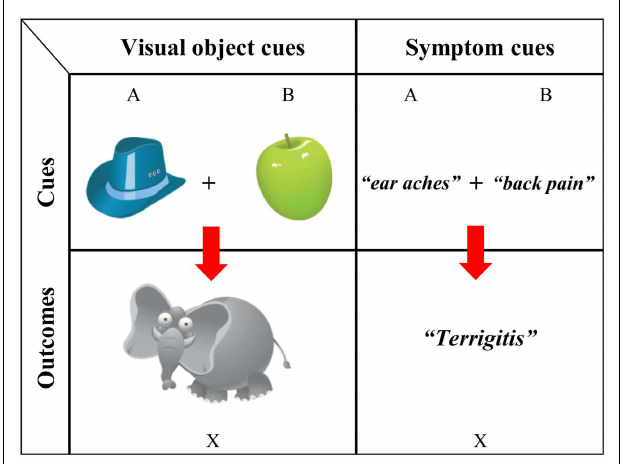
FIGURE 6 | Complete highlighting structure for visual stimuli used with